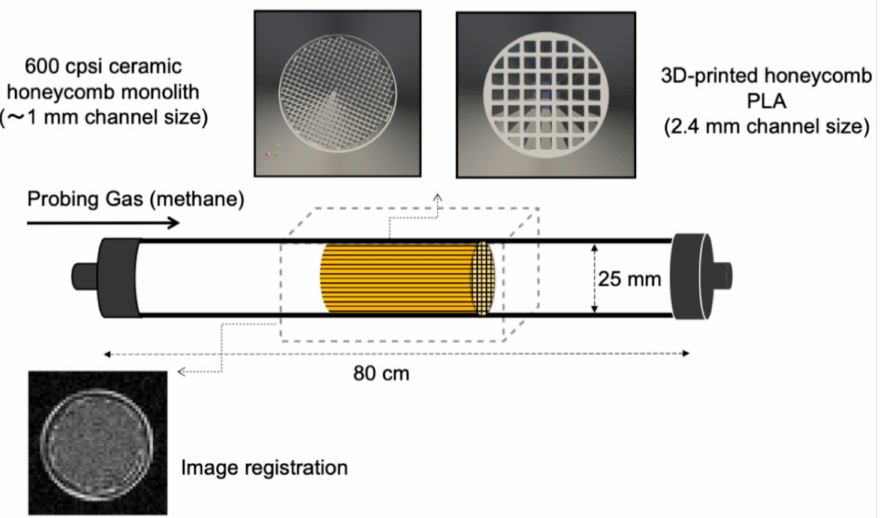
Figure 1. The experimental setup used for gas flow measurements in the 600 cpsi and 3D-printed honeycomb samples. The results of magnetic resonance velocimetry (MRV) and computational fluid dynamics (CFD) were compared by performing image registration for both data sets. The MRV image shows methane (bright pixels) in the commercial honeycomb. The bright ring shows the bulk of methane in the sealing cord around the sample used to fit the honeycomb in the